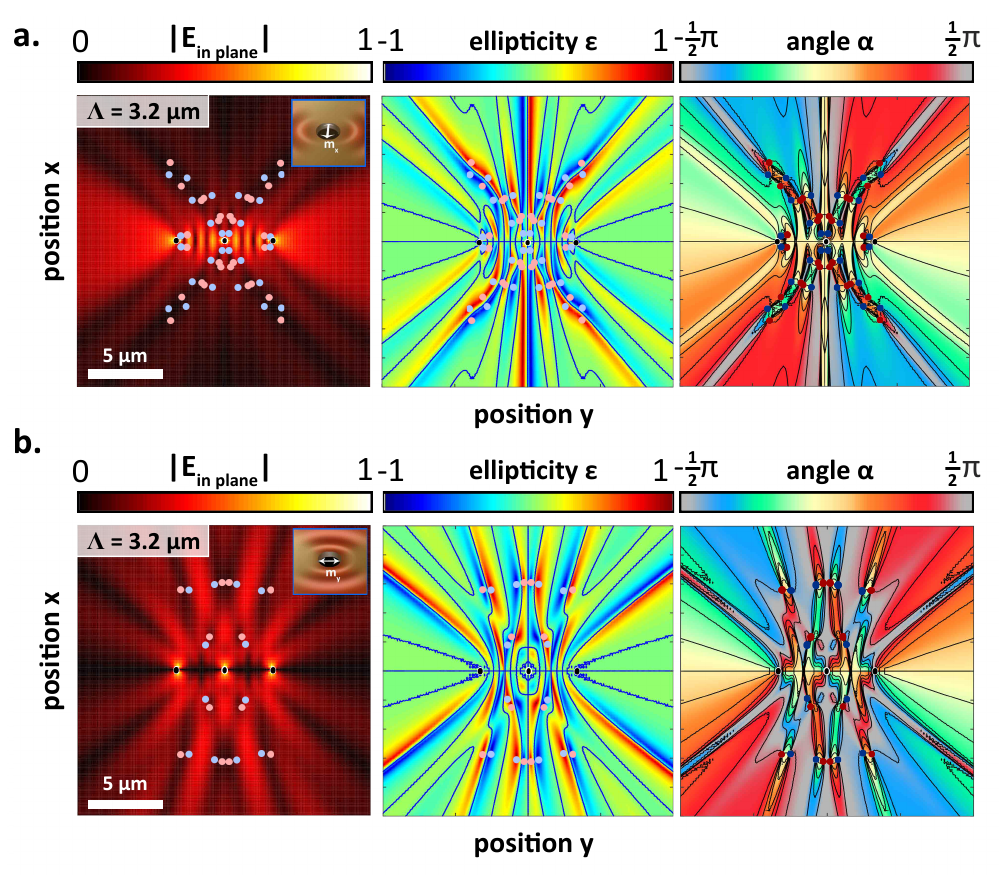
Figure 4. Light fields around three holes. Field amplitude, ε and α maps for three holes with 3.2- µ m separations when the incident response of the holes is dominated by ( a ) m dipoles. Both sets of maps clearly contain many